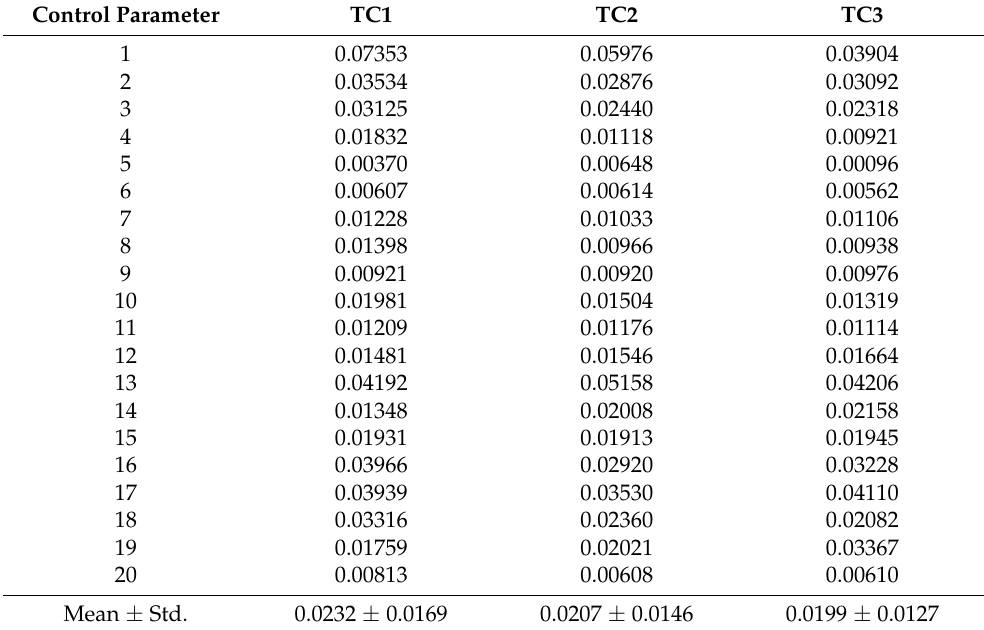
Figure 4. PECVD-based SiNx thin-film deposition process. ( a ) The real production process. ( b ) The schematic diagram of PECVD reaction process. ( c-h ) The data of control parameters collected from ( b ) The schematic diagram of PECVD reaction process. ( c – h ) The data of control parameters collected sensors. from sensors. Table 1. MAPE of generated control parameters under different training